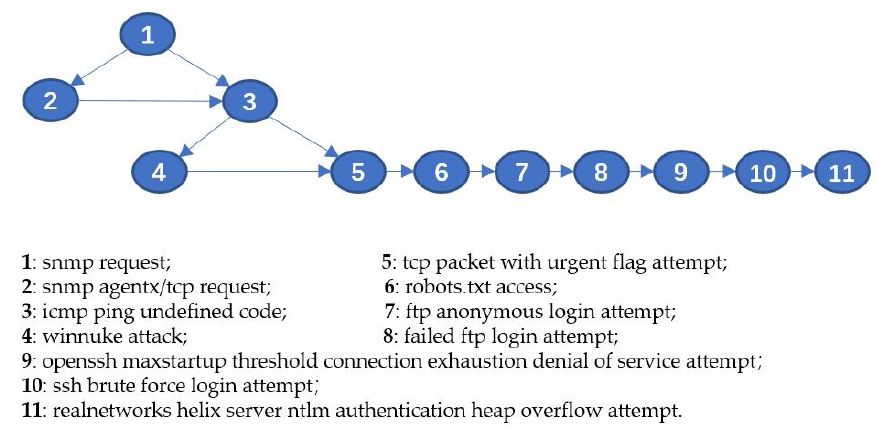
Figure 10. The discovered intrusion scenario.